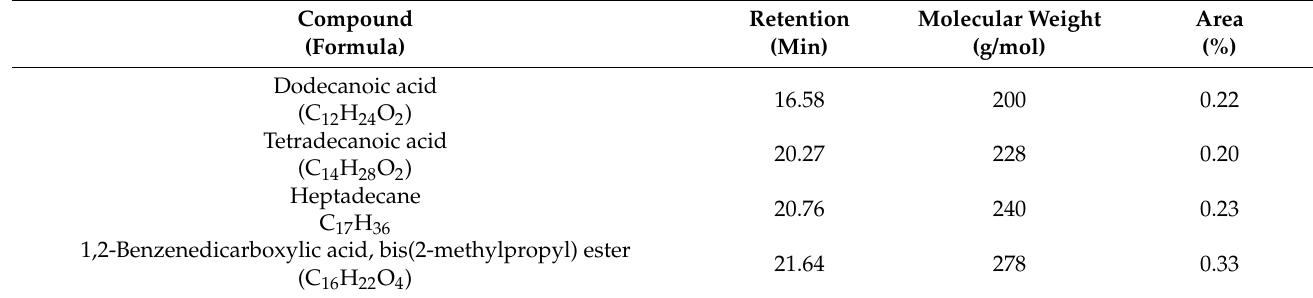
Table 5. Phytoconstituents of TCEA obtained from GC-MS